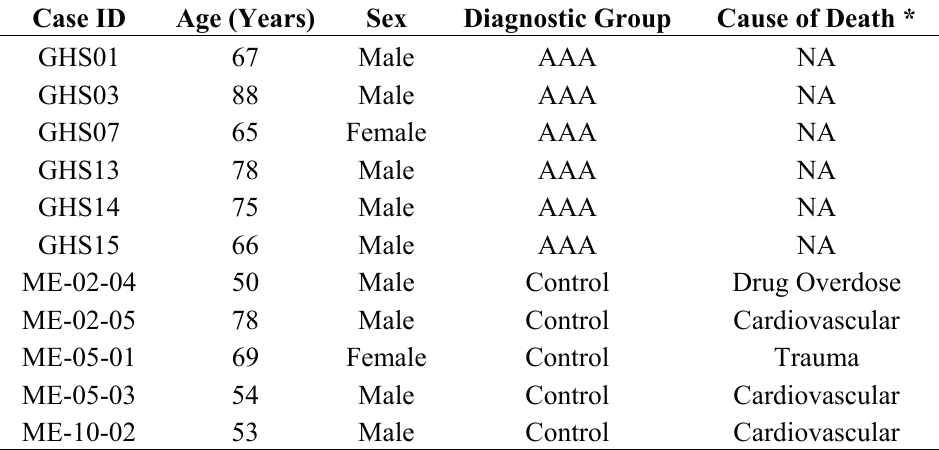
Table 2. Donor information for aortic tissue